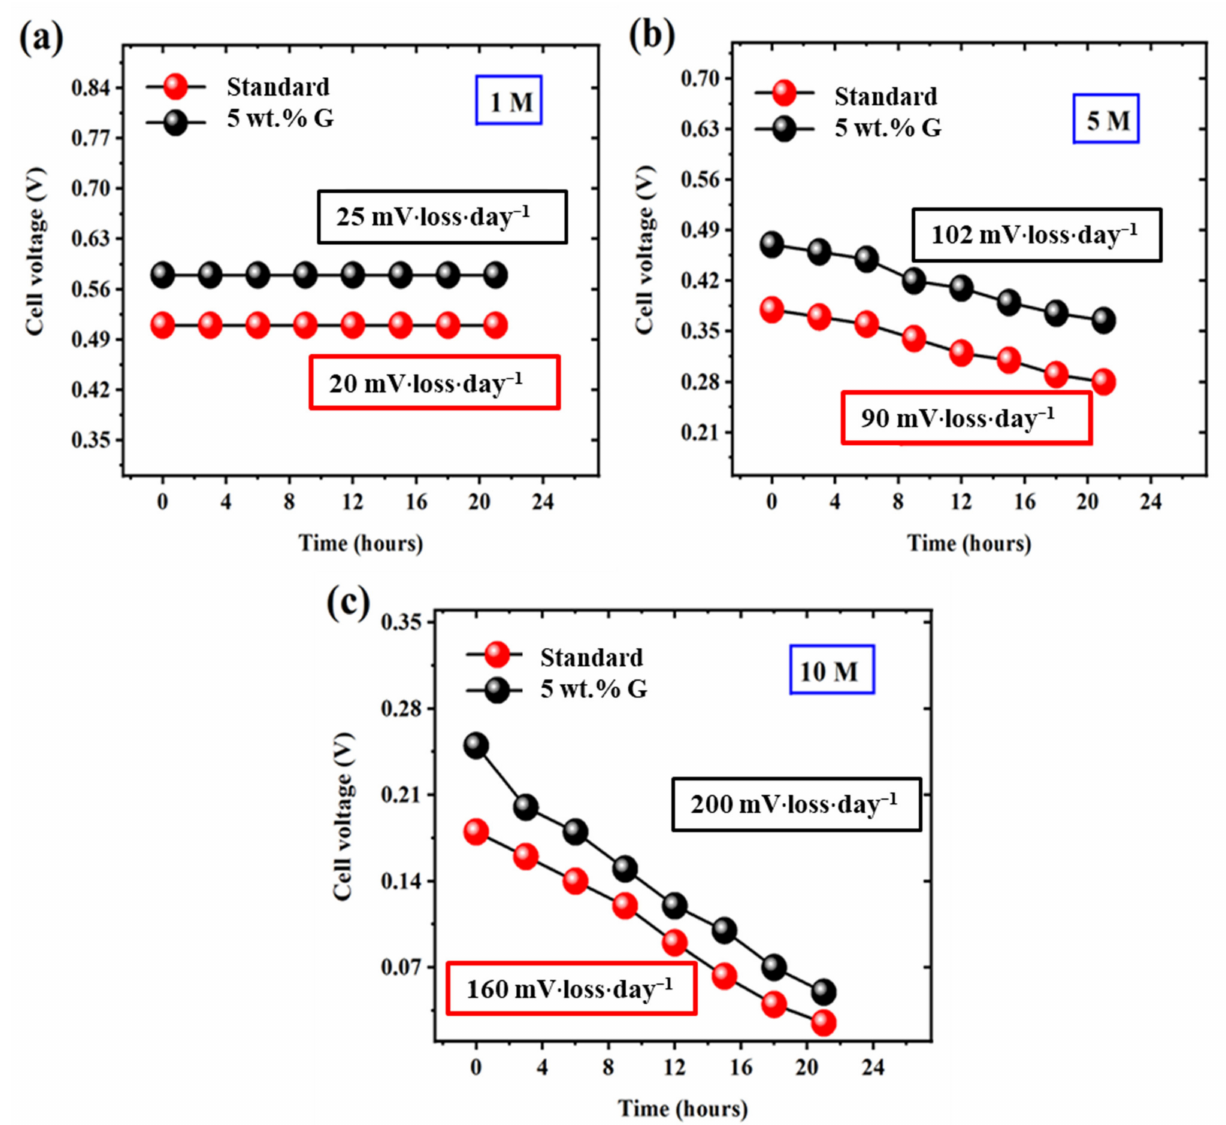
Figure 9. Long term voltage profile of standard and 5 wt.% graphene MEAs at ( a ) 1 M, ( b ) 5 M and ( c ) 10 M methanol